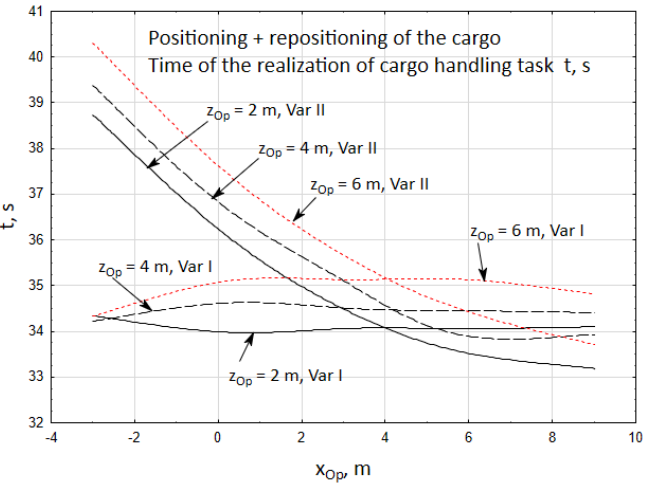
Figure 13. Time of the initial positioning of the cargo t , for two cases of the cargo handling task being realized.